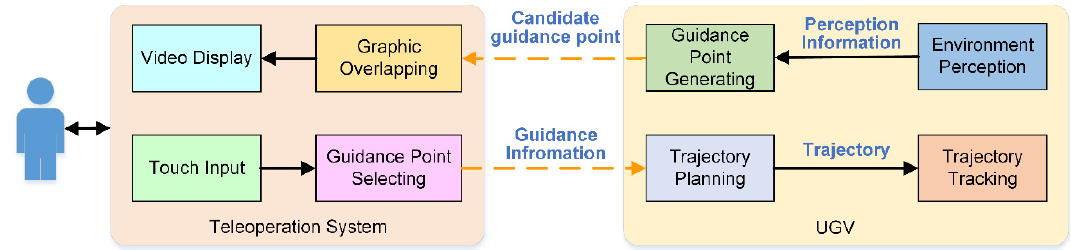
Figure 20. Human–machine interaction for cooperative